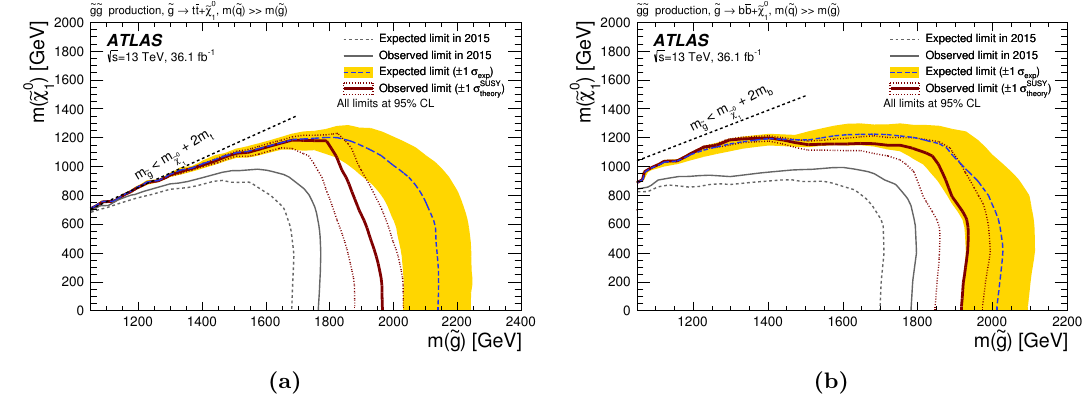
Figure 10. Exclusion limits in the ~ (cid:31) 0 1 and ~ g mass plane for the (a) Gtt and (b) Gbb models obtained in the context of the multi-bin analysis. The dashed and solid bold lines show the 95% CL expected and observed limits, respectively. The shaded bands around the expected limits show the impact of the experimental and background uncertainties. The dotted lines show the impact on the observed limit of the variation of the nominal signal cross-section by (cid:6) 1 (cid:27) of its theoretical uncertainty. The 95% CL expected and observed limits from the ATLAS search based on 2015 data [19] are also